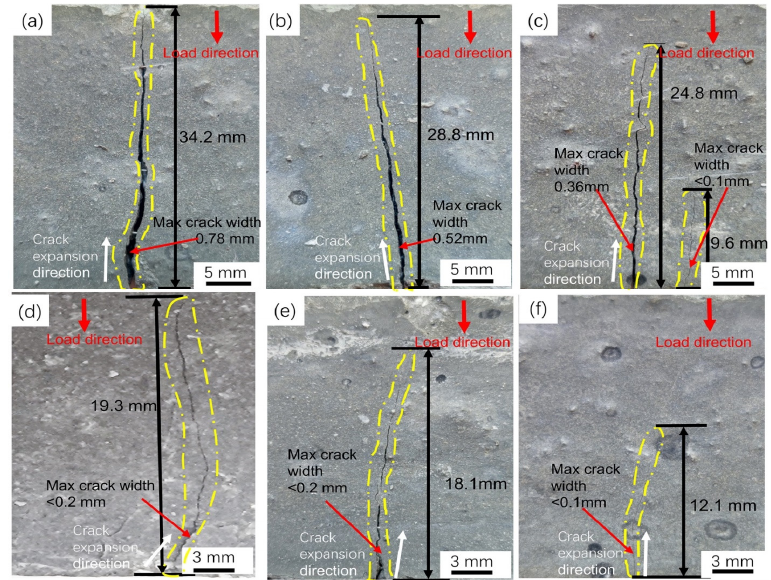
Figure 12. Crack patterns of straight BCSF-reinforced UHPC specimens with varying content of 1– 6 wt.% at 28 days after flexural strength test: ( a ) 1%; ( b ) 2%; ( c ) 3%; ( d ) 4%; ( e ) 5%; ( f ) 6%. Table 5. Crack patterns of straight BCSF-reinforced UHPC specimens with 1–6 wt.% at 28 days after flexural strength